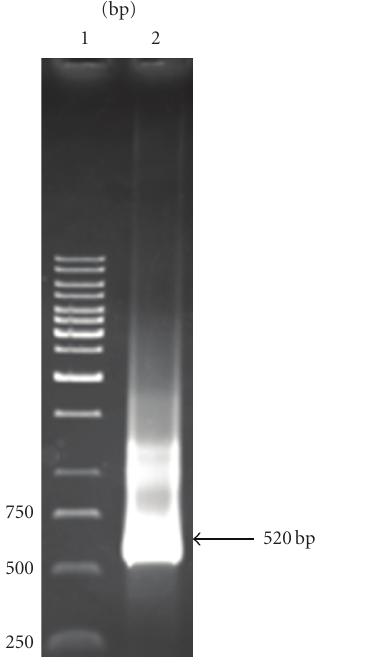
Figure 3: Confirmation of assembled plasmid containing the FGF1 gene . The pcDNA3.1/V5-His-TOPO-FGF1 plasmid was cleaved by Hin dIII and Xho I. Lane 1: DNA molecular weight markers. Lane 2: Two digestion fragments of 5433 bp and 561